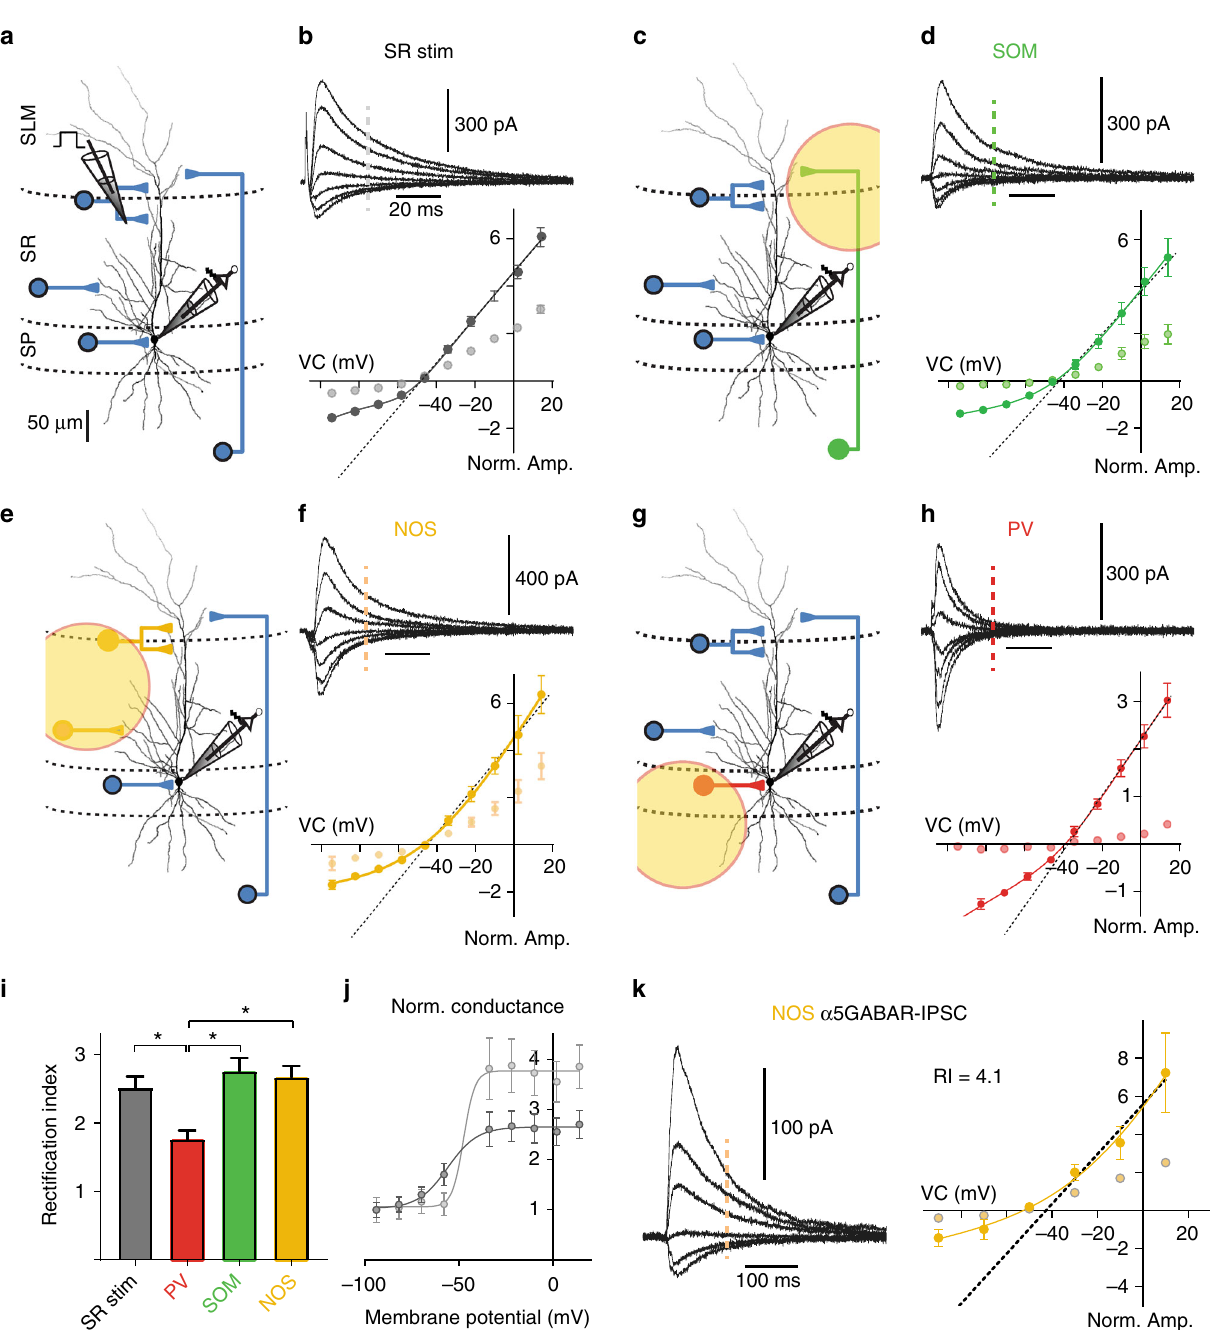
Fig. 4 Dendritic synaptic inhibition by SOM and NOS interneurons is strongly outward rectifying. a Experimental design for local stimulation of GABAergic inputs in the outer third of SR. b IPSCs evoked at the border between SLM and SR were recorded at different membrane potentials in the presence of 10 µ M NBQX and 25 µ M AP5 using a Cs-gluconate-based solution. Bottom, group data ( n = 11) show the mean IPSC amplitudes depending on the holding potential. Dark gray depicts the peak values, light gray the amplitude of the tail current measured at 30 ms after stimulation (indicated by dashed line in the top panel). The solid line represents a nonlinear fi t according to equation 1 (Methods), while the dashed line represents a linear fi t to values above – 40 mV. c – h The same for optogenetically activated inputs from speci fi c interneuron populations. Field of illumination relative to the recorded cell is indicated. i Mean recti fi cation indices (RI) were quanti fi ed as the ratio of the conductance extrapolated from the linear fi t to the outward currents above – 40 mV divided by the measured value at – 82 mV (1 = no deviation). The mean RI in PV-ChR2 stimulations ( n = 8) was signi fi cantly smaller than in all experiments with dendritic inputs (SR: P < 0.01; paired t test, n = 11; NOS: P < 0.001, n = 9; SOM: P < 0.001, n = 9). j The voltage dependence of the peak (dark gray) and tail conductance (light gray) for electrically stimulated dendritic inputs. Conductances were normalized to – 82 mV. k The grand mean of α 5-GABAR- mediated IPSCs from NOS-ChR-stimulated IPSCs ( n = 10) isolated by application of L-655,708 (50 nM). Mean IPSC amplitude is plotted against holding potential. Tail currents measured at 120 ms after stimulation are indicated (lighter shaded dots). The RI was calculated as the ratio of the conductance extrapolated from the linear fi t to the outward currents above – 40 mV (dashed line) divided by the conductance at – 82 mV interpolated by the nonlinear fi t to the measured PSCs (solid line). Recording temperature T ≈ 33 °C for a to j , and T ≈ 22 °C for